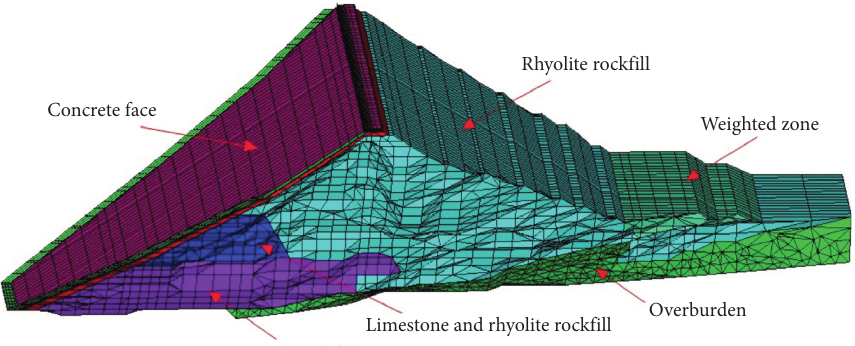
Figure 4: Three-dimensional finite element mesh of the Houziyan